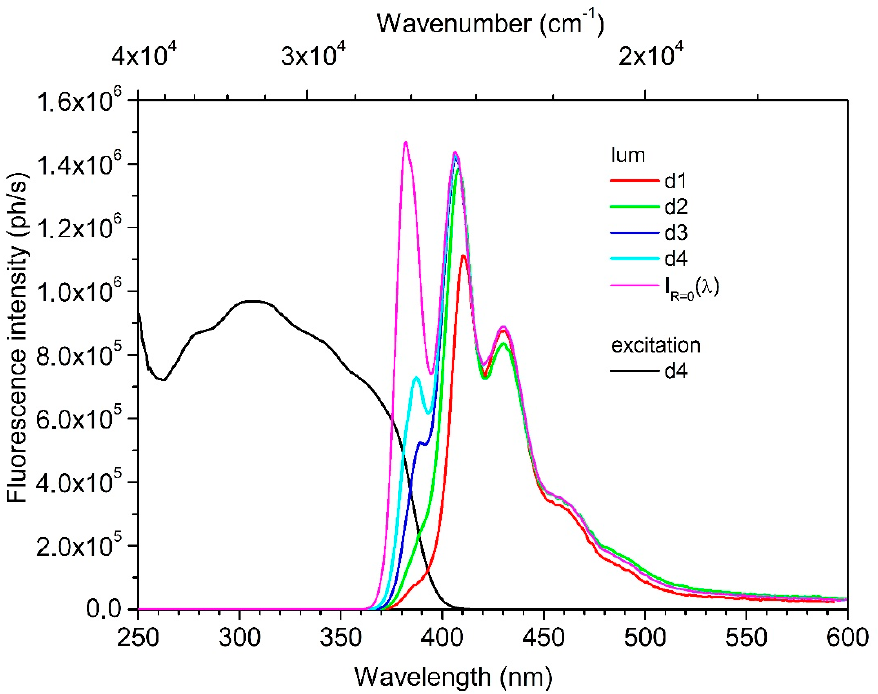
Figure 7. PL spectra of p-quinquephenyl crystals with different thicknesses d (d1 > d2 > d3 > d4) and the calculated spectrum without reabsorption I R = 0 ( λ ). The excitation wavelength was 325 nm. The luminescence excitation spectrum of the d4 crystal is shown by black solid line (the luminescence registration wavelength was 430 nm).